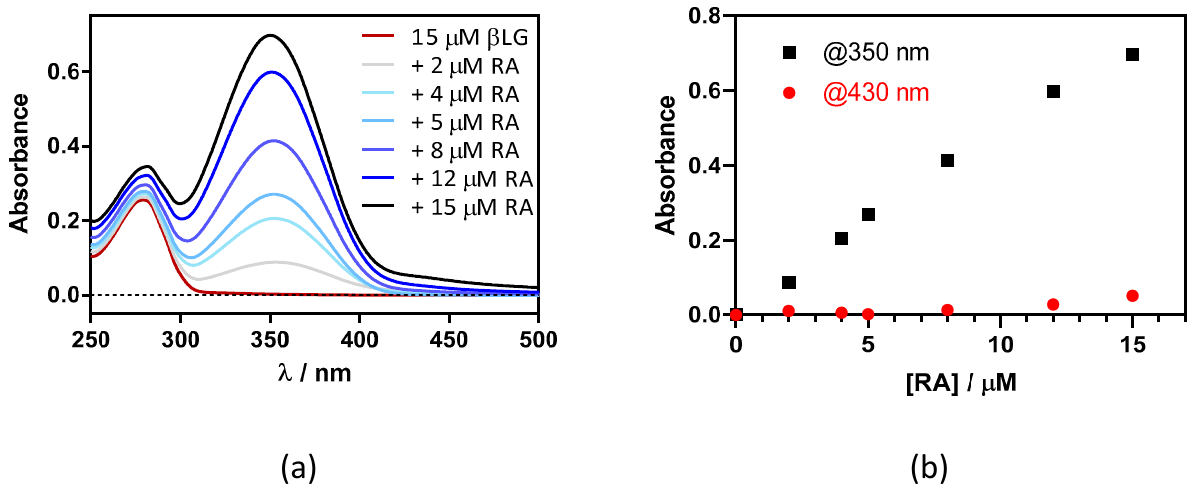
Figure 3. ( a ) Absorption spectra of retinoic acid (RA)– β -lactoglobulin ( β LG) mixtures at increasing RA concentrations (between 0 and 15 µ M). β LG concentration was fixed at 15 µ M. ( b ) The evolution of absorbance at 350 nm and 430 nm upon titration.